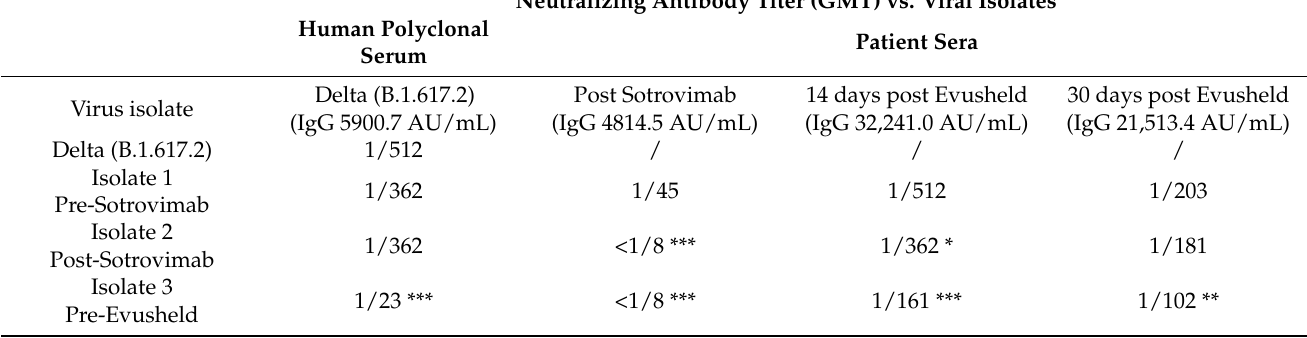
Table 2. Neutralizing antibody titers of patient sera tested either against Delta (B.1.617.2) strain and the three different patient isolates (pre- and post-sotrovimab, pre-Evusheld). All experiments were performed in triplicate. Statistical differences among GMTs were evaluated with respect to Isolate 1 (* p < 0.05; ** p < 0.01; *** p < 0.001).